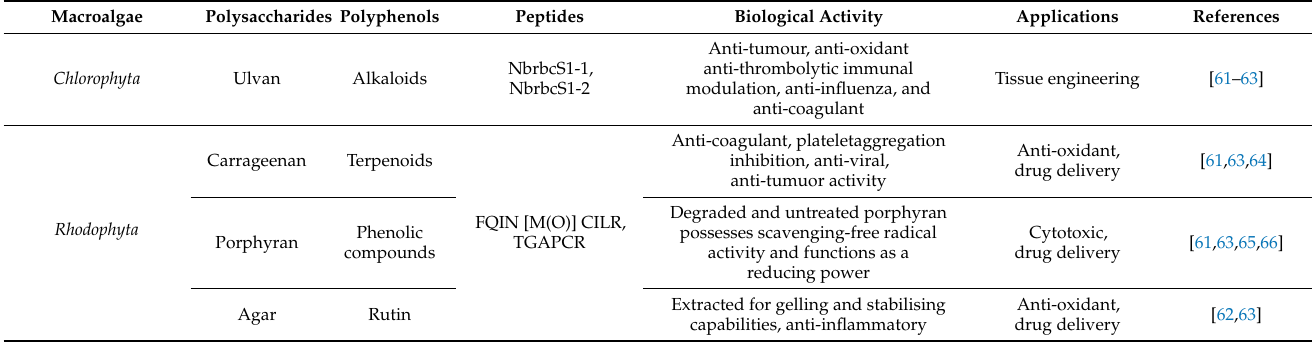
Table 3. Polysaccharides, polyphenols, peptides from macroalgae and their active